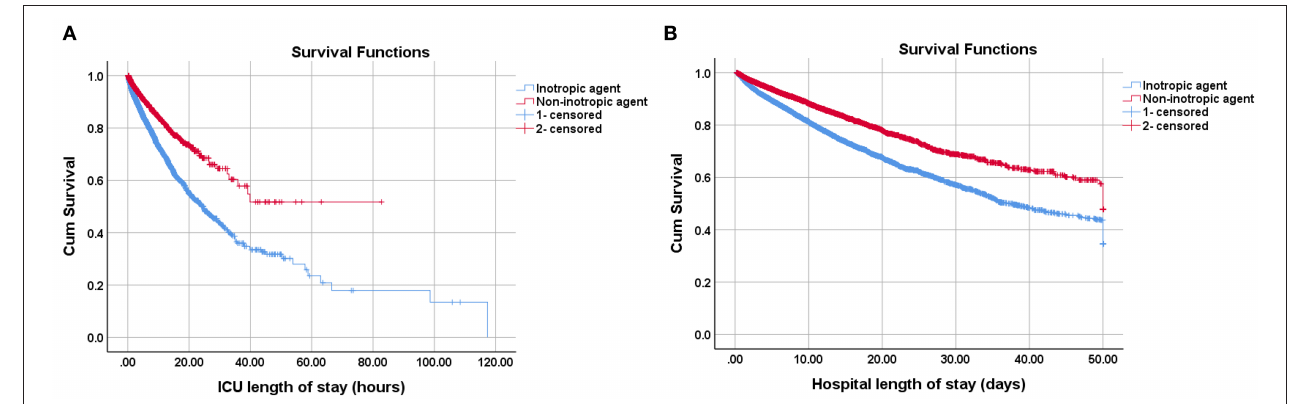
FIGURE 2 | Kaplan-Meier survival curves of cardiogenic shock patients receiving inotropic agents or not on (A) ICU and (B) hospital. The average survival hours of inotropic group and non-inotropic group in the ICU were 39.37 ± 2.90 and 51.95 ± 2.94h, P < 0.001; The average survival days of inotropic group and non-inotropic group in the hospital were 32.37 ± 0.31 and 37.61 ± 0.36 d, P < 0.001. The survival curves were performed by Log Rank method.